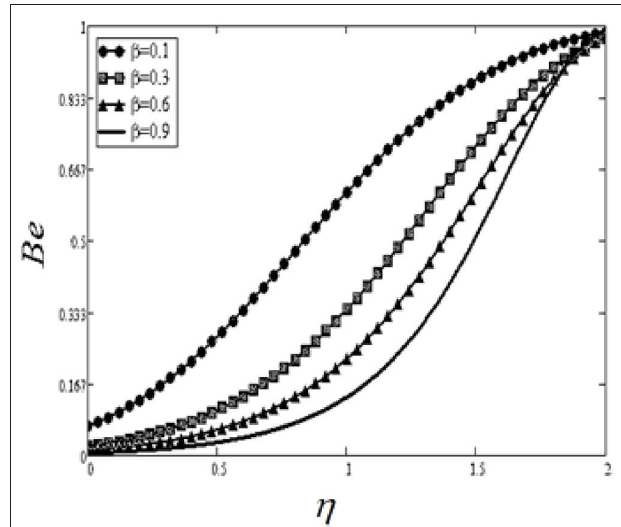
FIGURE 11 | Bejan number plot for (cid:127) .